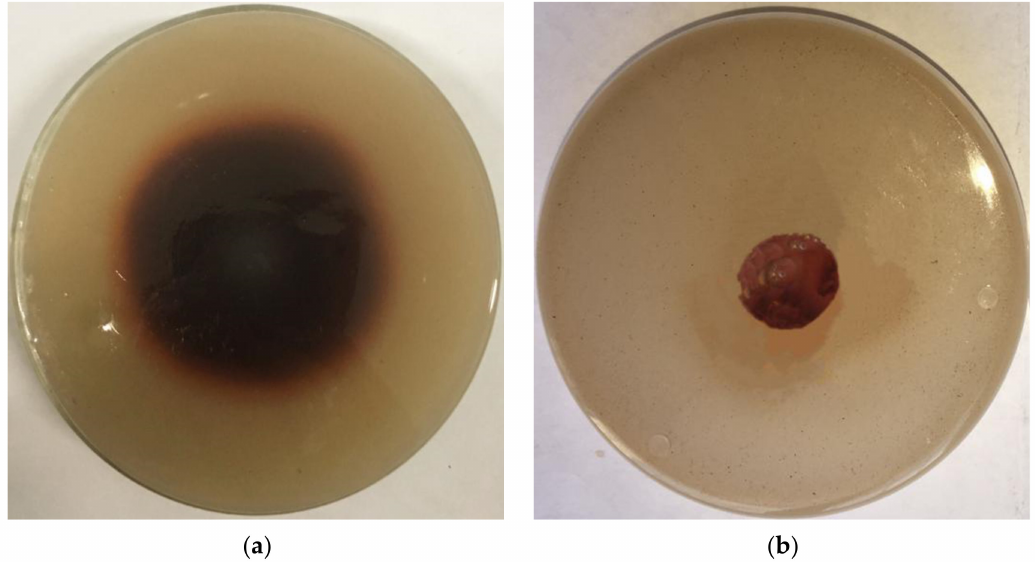
Figure7. Colorchangingcircleexperiment. ( a )RecombinantlaccaseX33-Lac-2; ( b